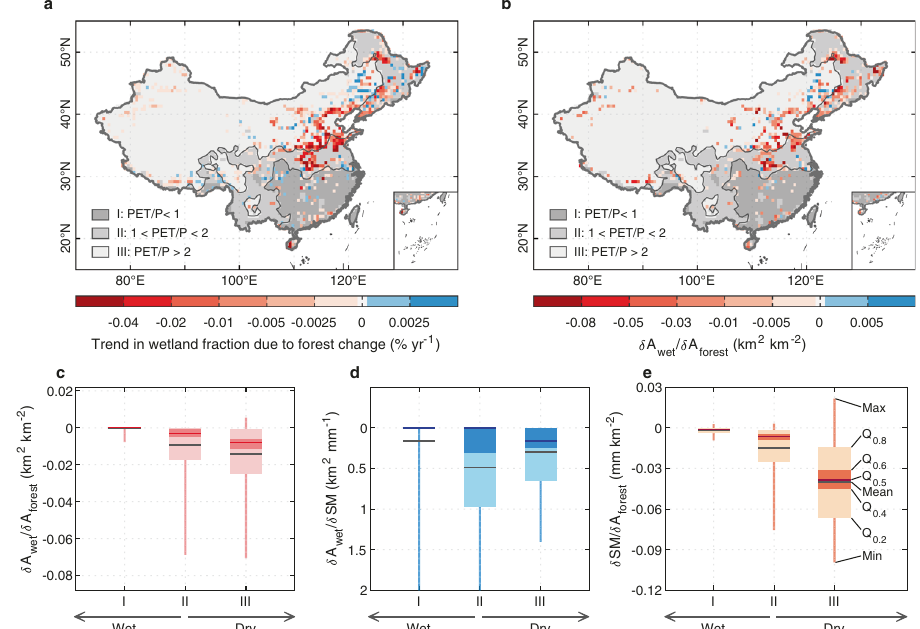
Fig. 3 Historical wetland change in response to forest change in China. a , b Spatial patterns of wetland change due to the forest change ( a ) and its sensitivity to forest change ( b ) from 2000 to 2016, with the average annual ratio of potential evapotranspiration (PET) to precipitation (P), (PET/P) as background. The trends in Fig. ( a ), ( b ) are estimated by linear least-squares regression and hatching indicates the trend is statistically signi fi cant ( t -test, p < 0.05). c – e Sensitivity of wetland change to forest change ( δ A = δ A δ A = δ SM) ( d ), and SM wet forest ) ( c ), wetland change to soil moisture (SM) change ( wet change to forest change ( δ SM = δ A forest ) ( e ), at grid scale for three climate zones divided by PET/P as shown in Fig. a . Please note that in order to clearly show the statistical results of three sensitivities, the grid cells with no forest from 2000 to 2016, or no change in forest cover fraction, or a less than 1% wetland fraction from RFW are not considered, and the outliers outside of the range of 5th – 95th percentiles are dropped in Fig. b ‒ e . This results in n = 322, n = 317, and n = 243 for three climate zones, respectively in Fig. c ‒ e . The whiskers and boxes in Fig. c – e indicate the maximum (Max), 80% (Q 0.8 ), 60% (Q 0.6 ), 50% (Q 0.5 ), 40% (Q 0.4 ), 20% (Q 0.2 ), minimum (Min), and mean (Mean) sensitivity of all grid cells in each climate zone after dropping